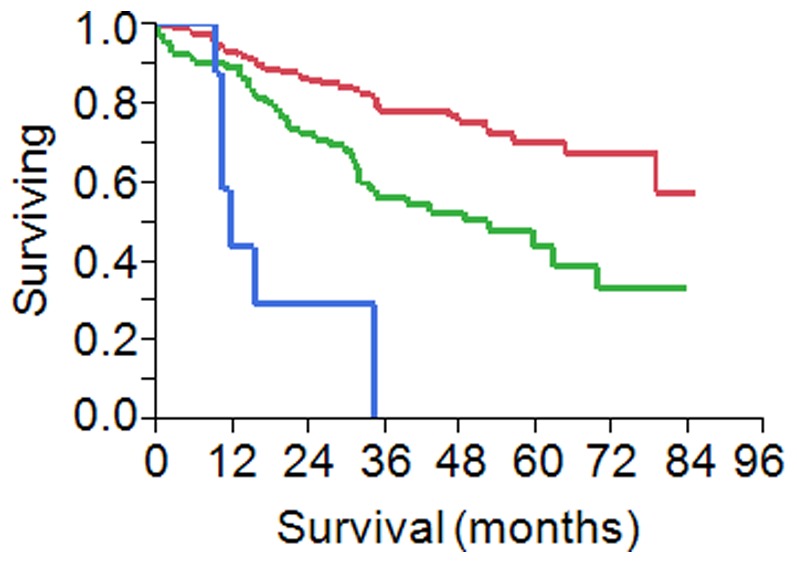
Kaplan-Meier analysis according to stage of the clinical group of 267 patients enrolled in this retrospective analysis.In red stage I–II patients (n = 176), in green stage III patients (n = 82) and in blue stage IV (n = 8).